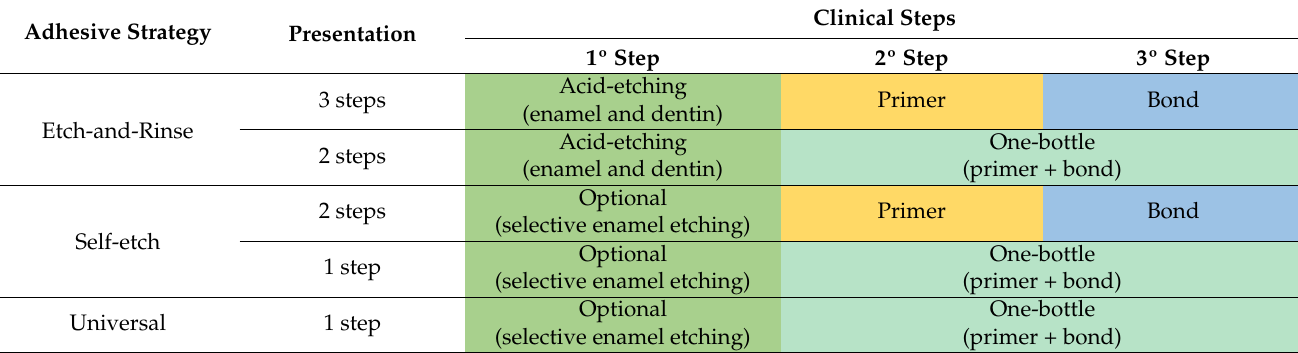
Table 1. Adhesive strategy, presentation, and clinical steps of adhesive systems application. Adhesive